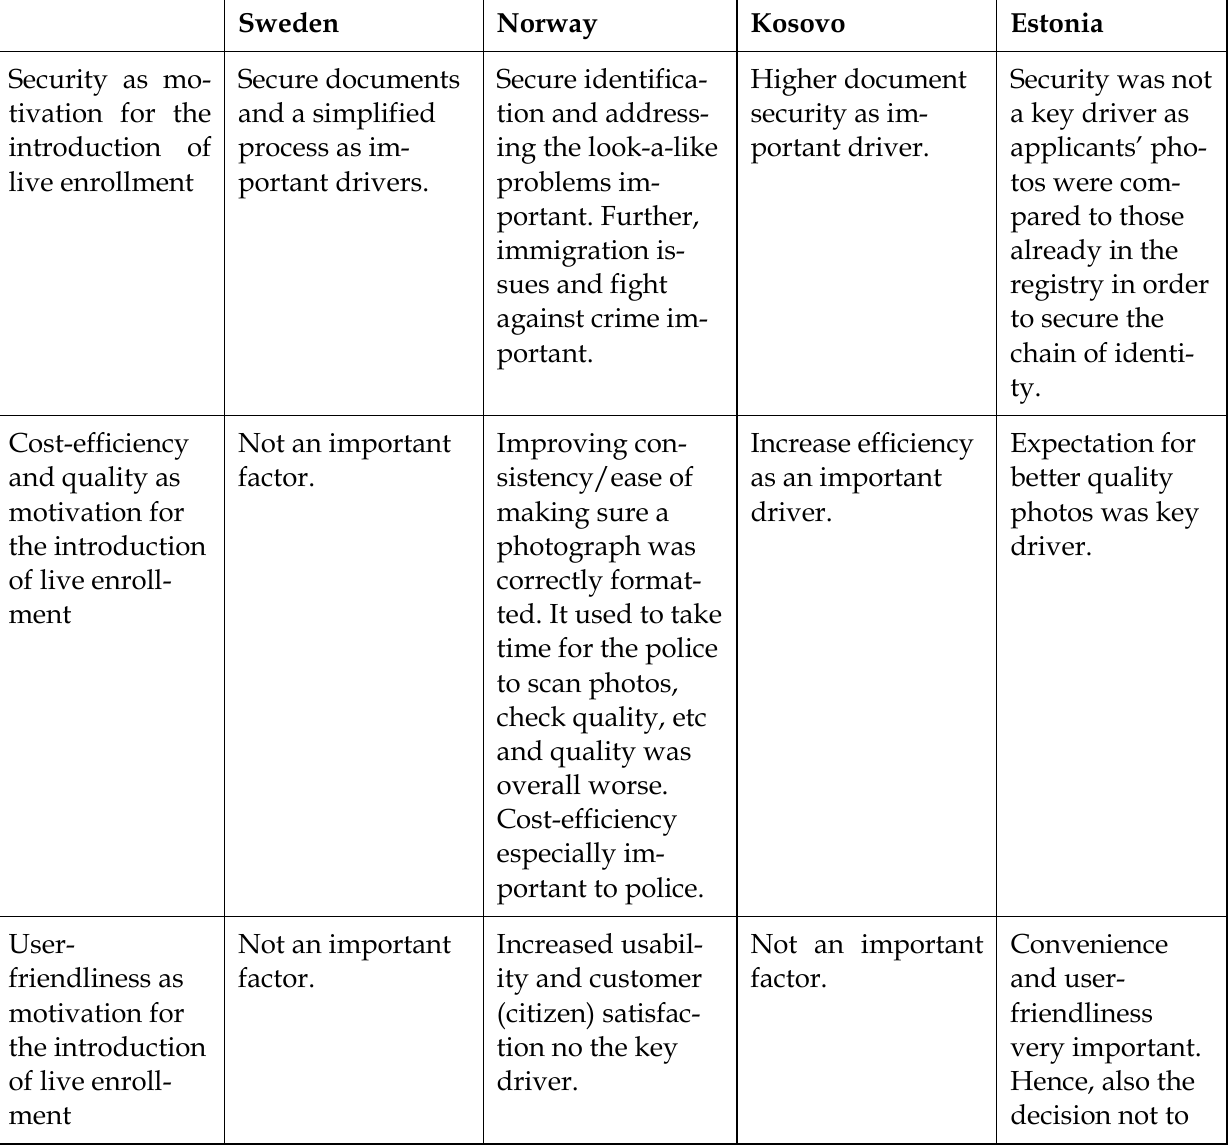
Table 2: Motivational factors in Sweden, Norway, Kosov,o and